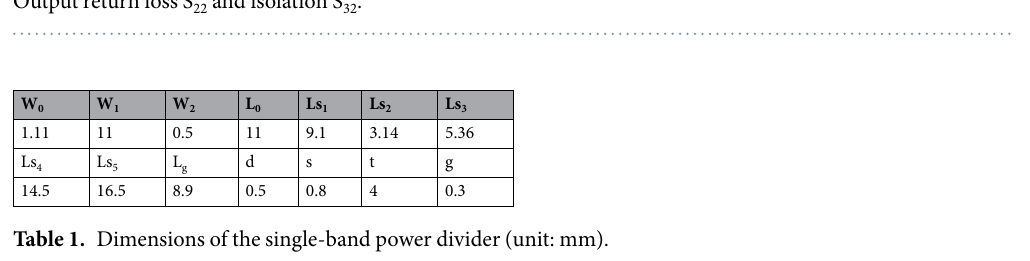
Figure 14. Photograph and results of the fabricated power divider. ( a ) Simulated and measured S 11 and S 21 ( b ) Output return loss S 22 and isolation S 32 .